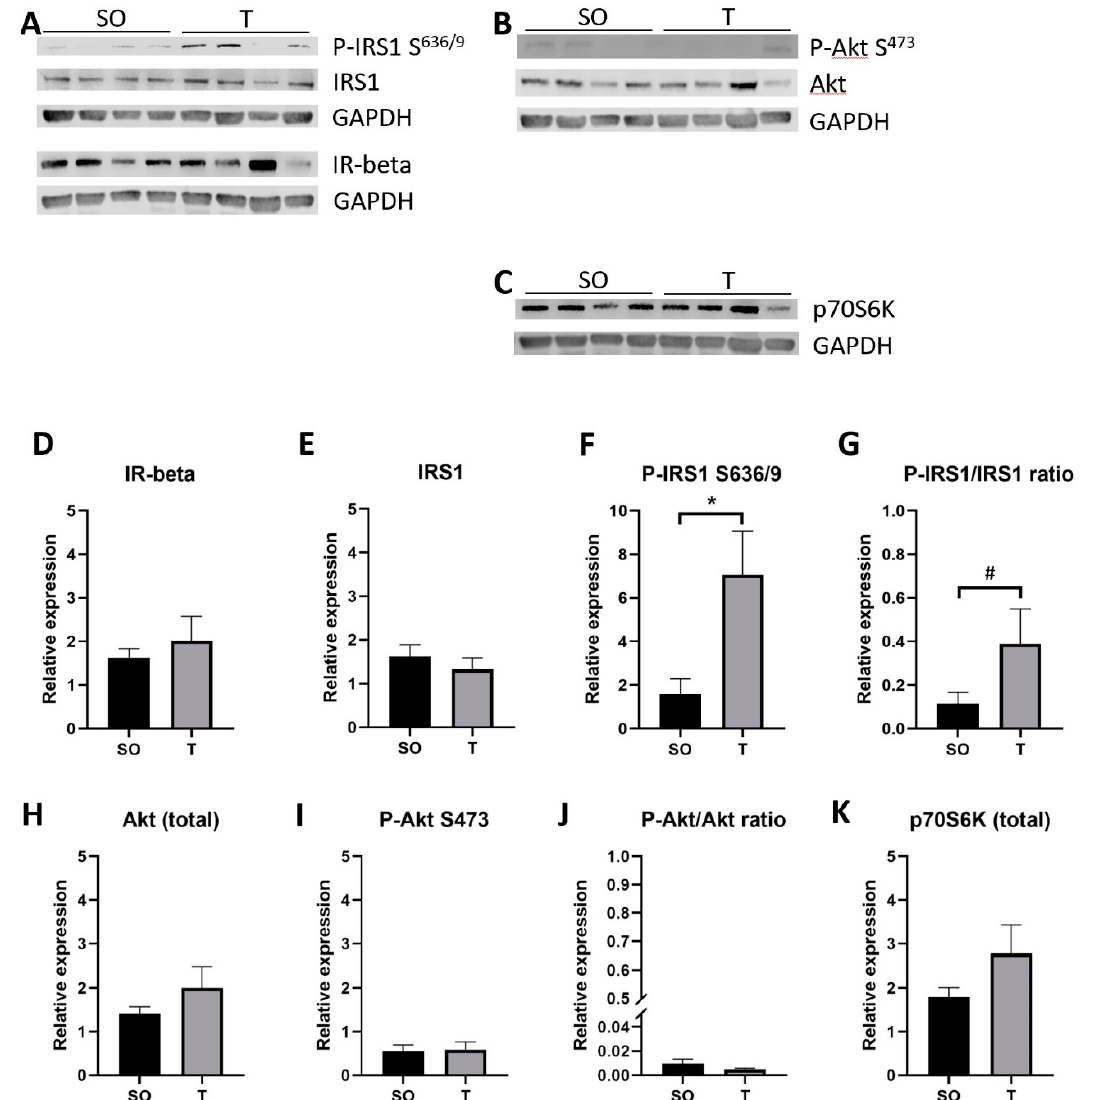
Figure 11. Greater Ser 636/9 phosphorylated IRS1 expression in PNA soleus muscle. Soleus muscles from 16-week-old rats were homogenized on ice in buffer containing protease and phosphatase inhibitors. ( A – C ) Homogenates (30 µg) were separated by SDS-PAGE prior to transfer to nitrocellulose for immunoblot analysis of proteins. ( D – K ) Band intensity was quantified using ImageStudio Lite software (Version 5.2), and data were analyzed using unpaired t tests. Expression of Ser 636/9 phosphorylated IRS1 protein was greater in soleus from PNA rats ( A , E ); IRS1 expression was comparable, resulting in a trend toward increased P-IRS1 to total IRS1 ratio in soleus from PNA rats ( G ; # p = 0.10). Means with SD are shown. * p < 0.05.